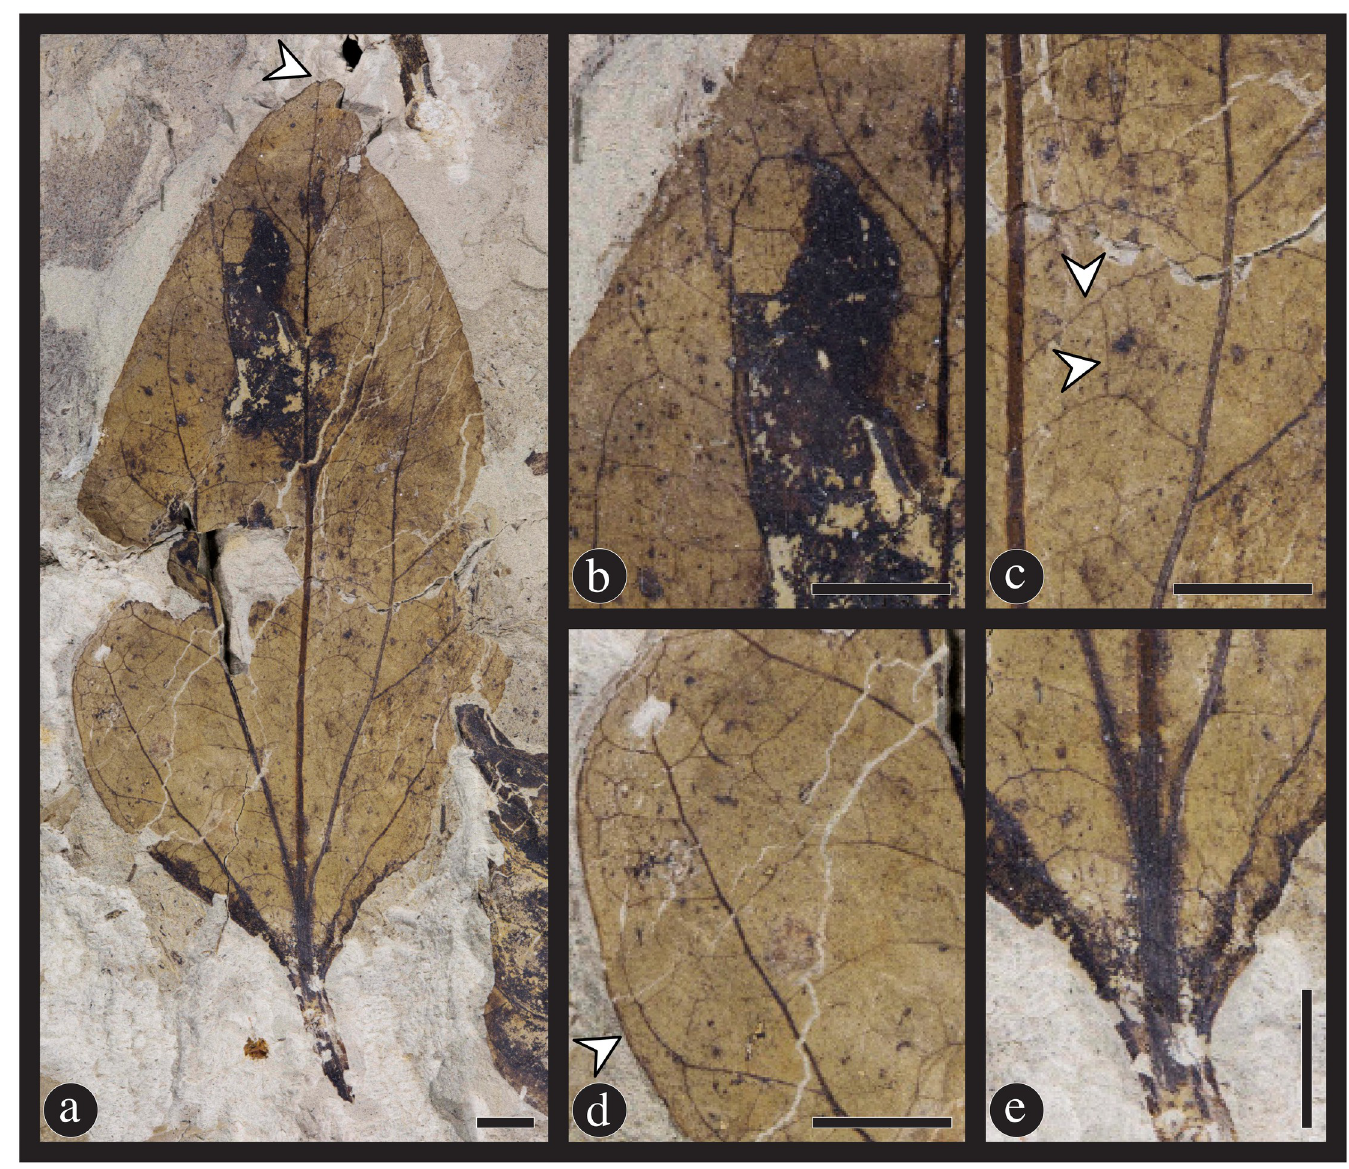
Fig 4. Overall and detail images of the holotype specimen (DMNH 54376, DMNH loc. 4150) of Catula gettyi Maccracken et al., gen. et sp. nov. (A) Complete leaf. Arrow indicates mucronate apex. (B) Detail showing upper left section of the leaf with looping and simple brochidodromous secondary venation. The dark area on the leaf is a blotch mine. The primary vein of the leaf parallels the right side of the figure. (C) Detail showing a medial section on the right side of the leaf, with the primary vein on the left side of the figure. Note the epimedial tertiary veins with variable course (upper arrow), and the irregular to regular reticular quaternary venation (lower arrow). (D) Detail showing lower left section of the leaf with simple agrophic veins, looping ultimate marginal venation, and a fimbrial vein indicated by arrow. (E) Detail showing the base of the leaf with 2 pairs of acute basal secondary veins and laminar tissue extending down the petiole. Note the decrease in the primary vein width with the departure of the secondary veins. All scale bars = 0.5